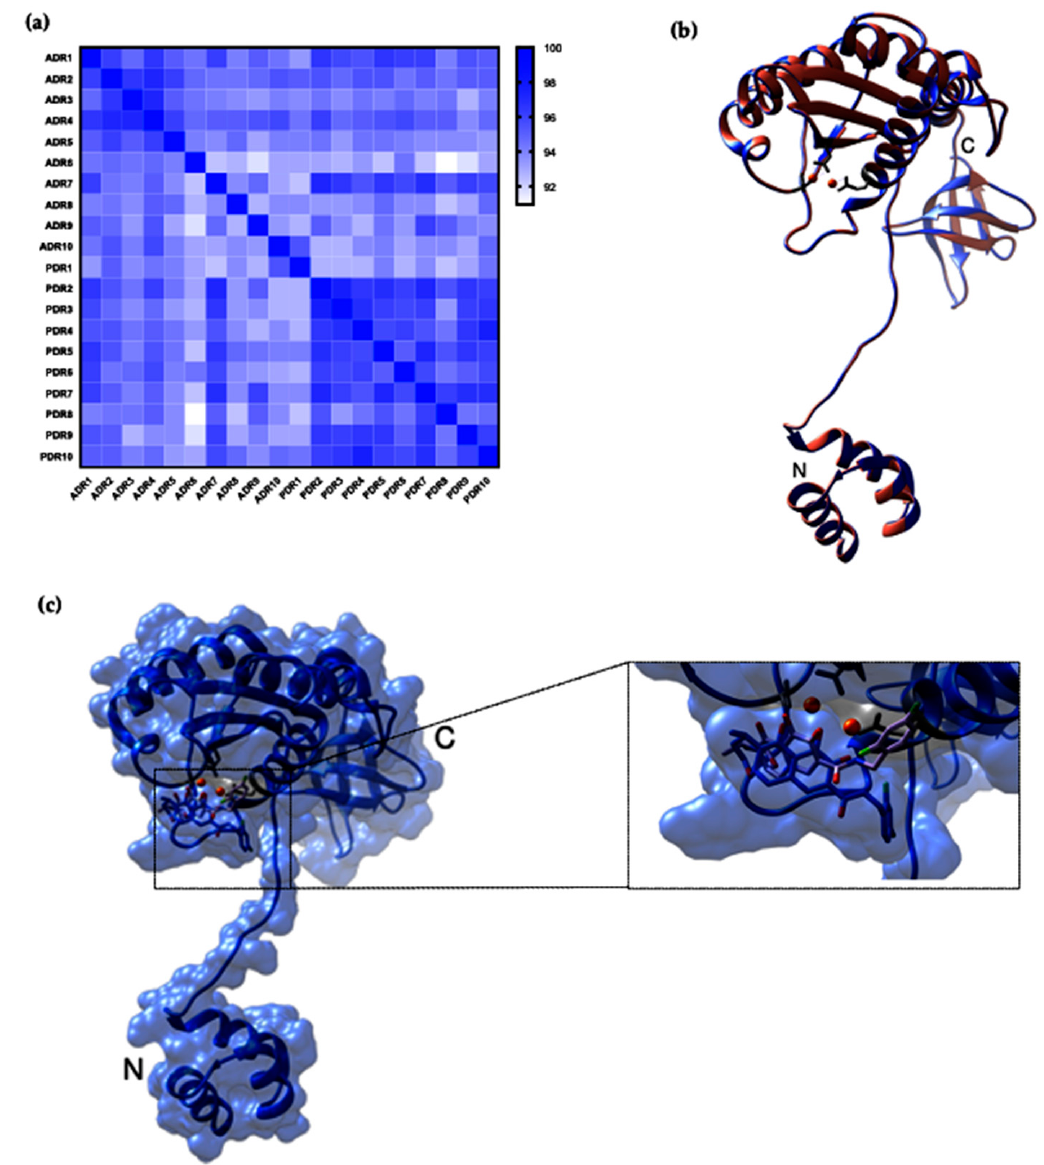
Figure 7. Visualization of HIV-1 IN amino acid sequences from ART-naive (PDR) and ART-experi- enced drug-resistant (ADR) individuals. ( a ) Heat map of amino acid identities of HIV-1 IN amino acid sequences from PDR and ADR individuals. The heat map was generated using a percent iden- tity matrix table created in Clustal 12.1, and the heat map was visualized in GraphPad Prism 8. ( b ) For in silico predictions, a molecular model of the monomeric HIV-1 integrase structure 6u8q was used and modified based on the multiple-sequence alignment of amino acid sequences of 10 ADR and 10 PDR sequences. Figures were created in Chimera (https://www.cgl.ucsf.edu/chimera